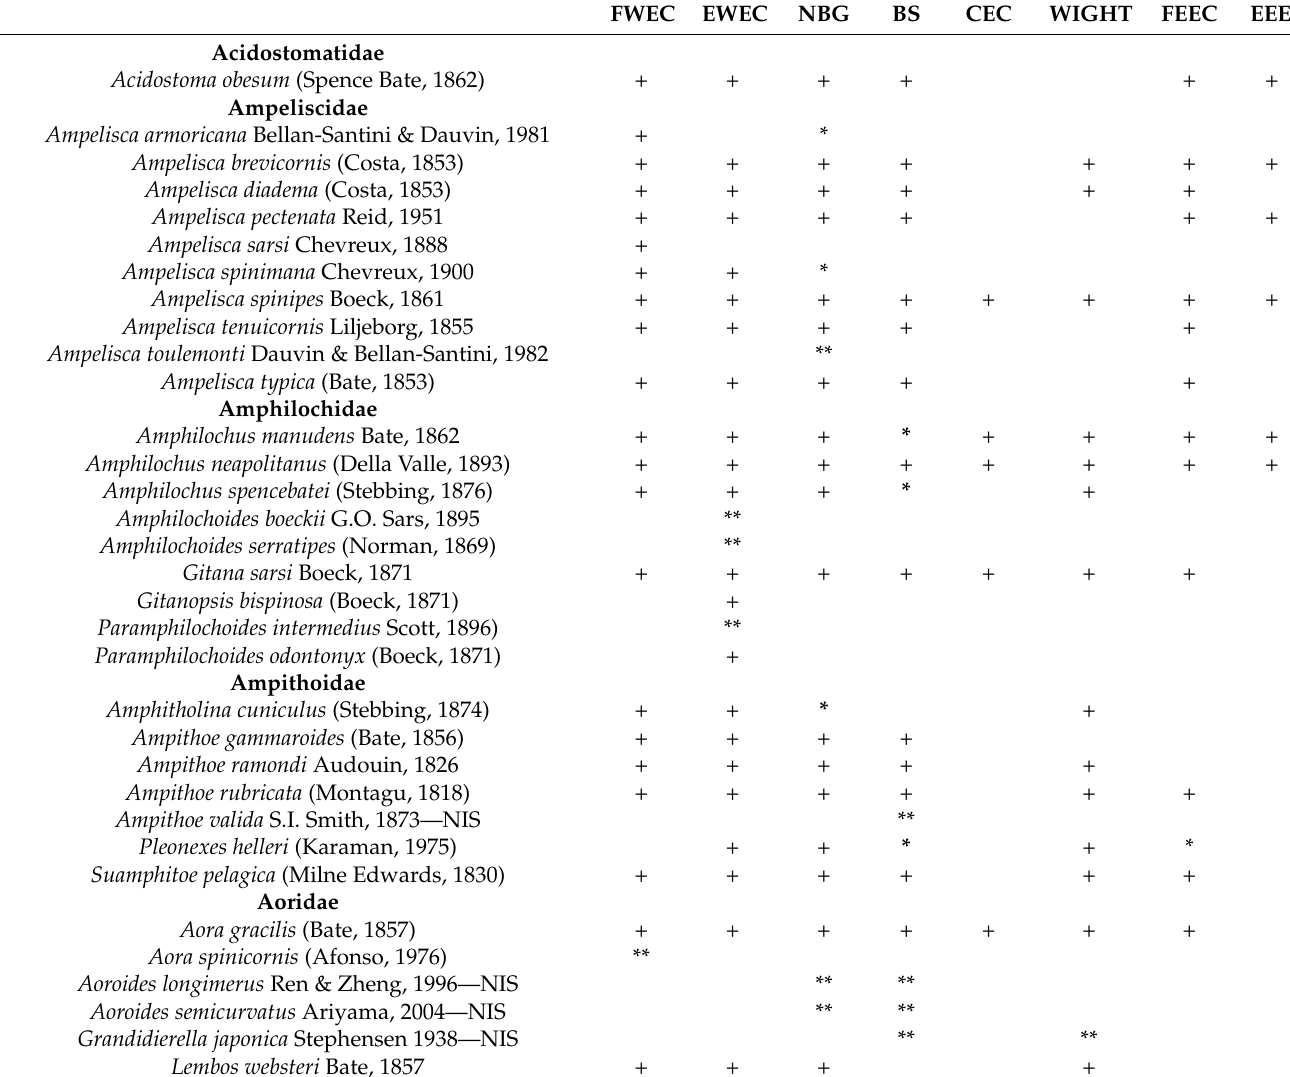
Table 2. Checklist of amphipods in the English Channel. NIS: Non-Indigenous Species.